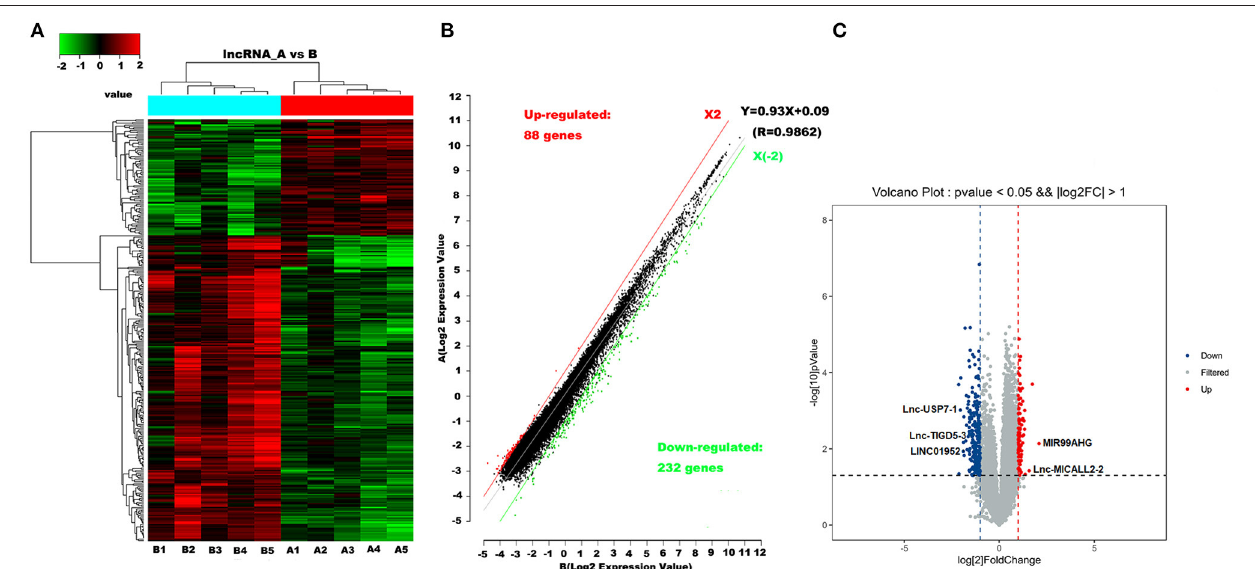
FIGURE 1 | Differentially expressed lncRNAs in CHD vs. non-CHD subjects. (A) Heat map analysis from 10 samples in the CHD subjects (A1, A2, A3, A4, and A5) and non-CHD subjects (B1, B2, B3, B4, and B5) revealed different lncRNA expression profiles. The red color indicates relatively up-regulated lncRNAs, and the green color represents relatively down-regulated lncRNAs; the black portions indicate no significant difference. (B,C) Olcano plot and scatter plot analysis of differentially expressed lncRNAs in CHD and non-CHD subjects. Red or green points represent up-regulated or down-regulated lncRNAs (fold change > 2.0, p < 0.05), respectively.